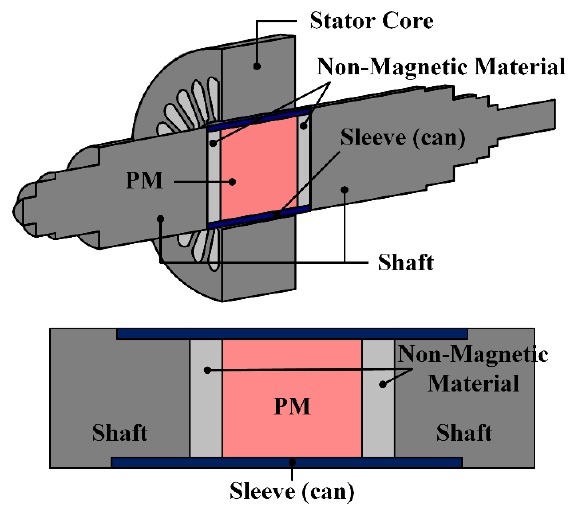
Figure 1. Structure of a permanent magnet motor.